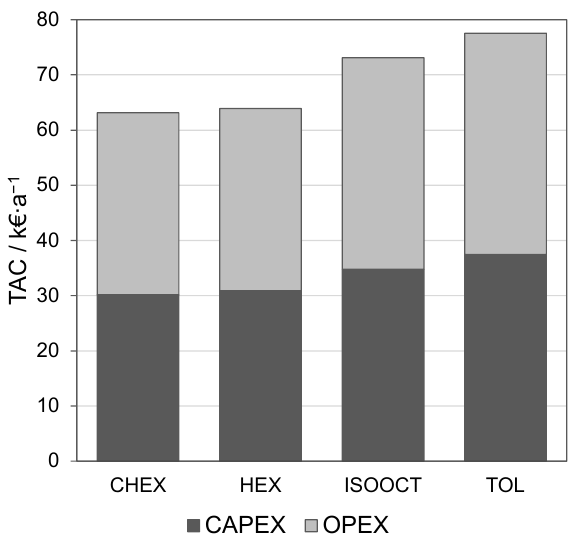
Figure 4. Total annualized costs (TAC) for the solvents cyclohexane (CHEX), hexane (HEX), iso- octane (ISOOCT) and toluene (TOL) separated in capital expenditures (CAPEX) and operational expenditures